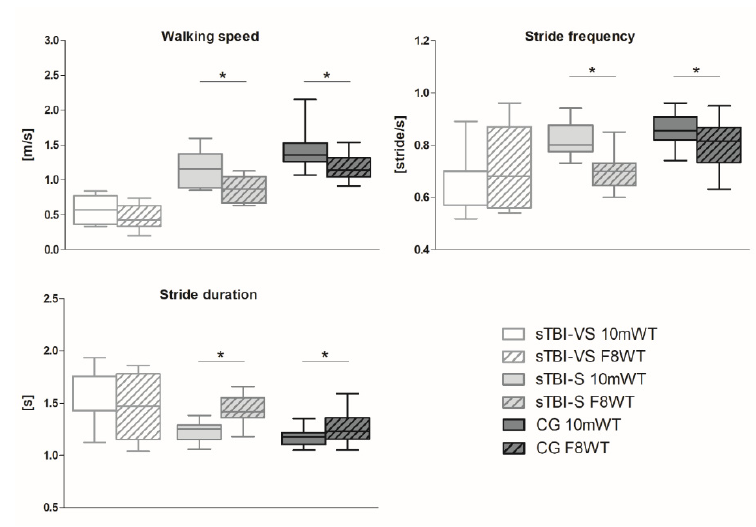
Figure 2. Whisker’s plots reporting walking speed, stride frequency, and stride duration for both the 10mWT and the F8WT in sTBI-VS, sTBI-S, and CG. In all subplots, the horizontal lines with asterisks indicate statistically significant differences.